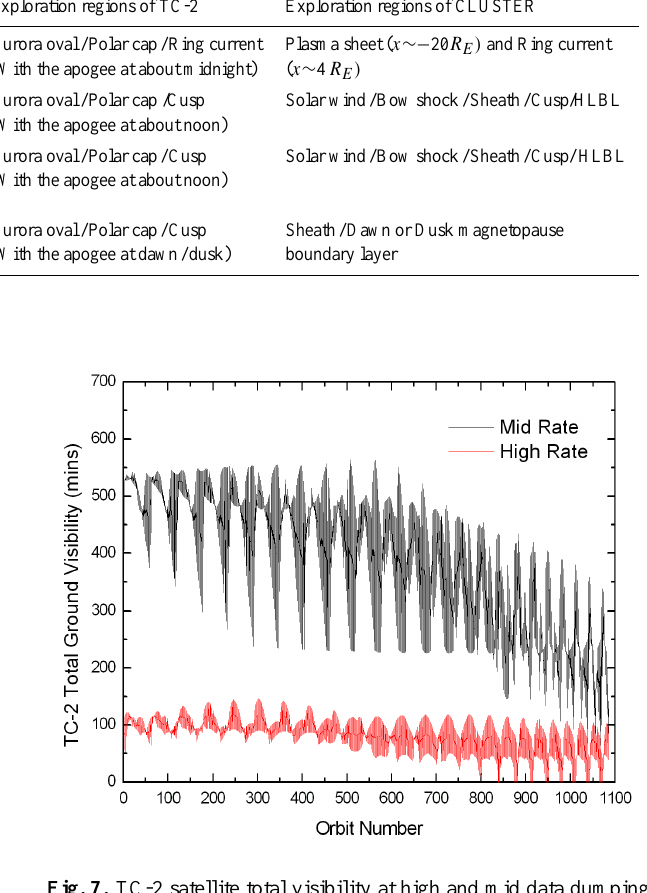
Fig. 7. TC-2 satellite total visibility at high and mid data dumping rates from the three ground